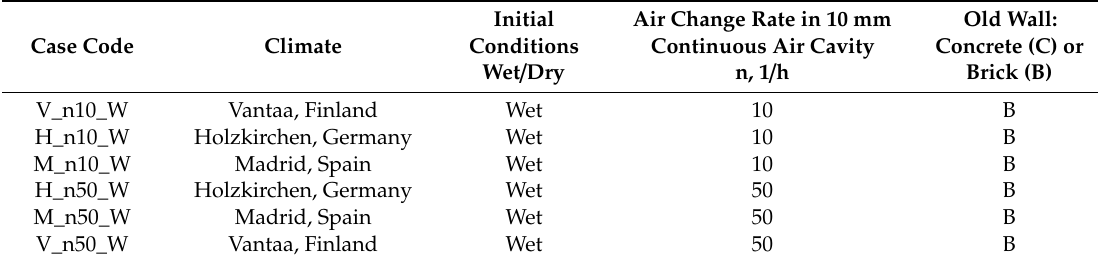
Table 8. Numerically analyzed cases for ventilation scheme